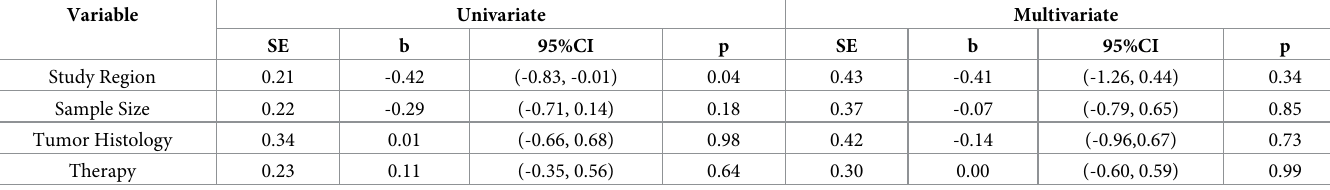
Table 2. Result of